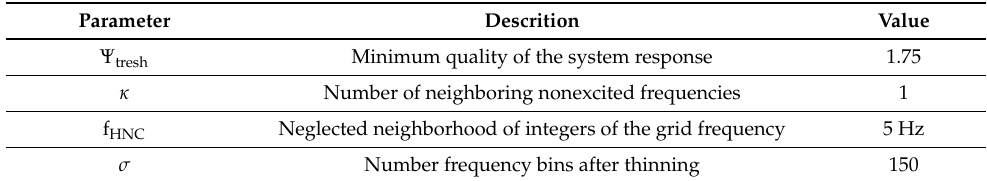
Table 4. Parameters of excitation